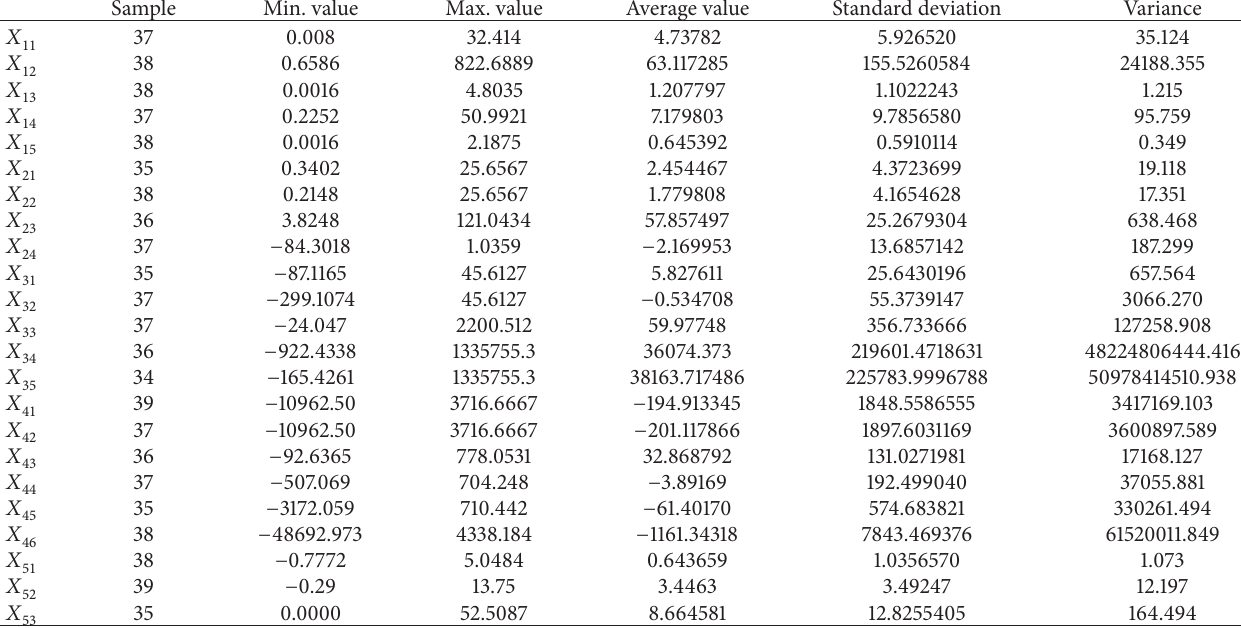
Table 4: Descriptive statistics of